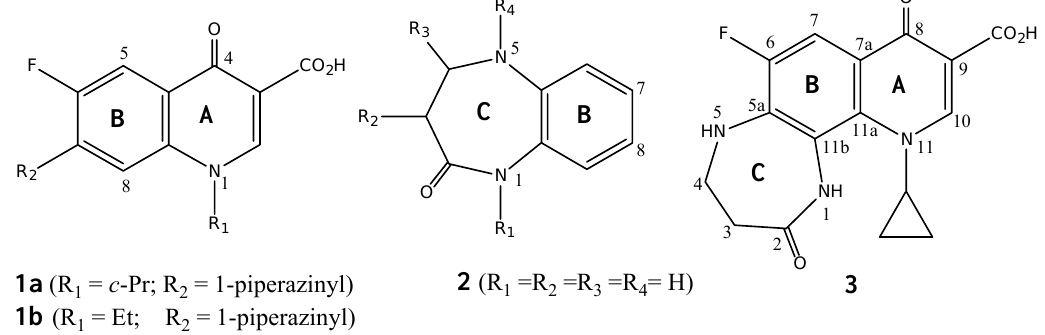
Figure 1. Structures of fluorquinolones 1a , 1b , 1,3,4,5-tetrahydro-2 H -benzo[ b ][1,4]- diazpine-2-one ( 2 ) and 2,8-dioxohexahydro-1 H -[1,4]diazepino[2,3- h ]quinoline carboxylic acid ( 3